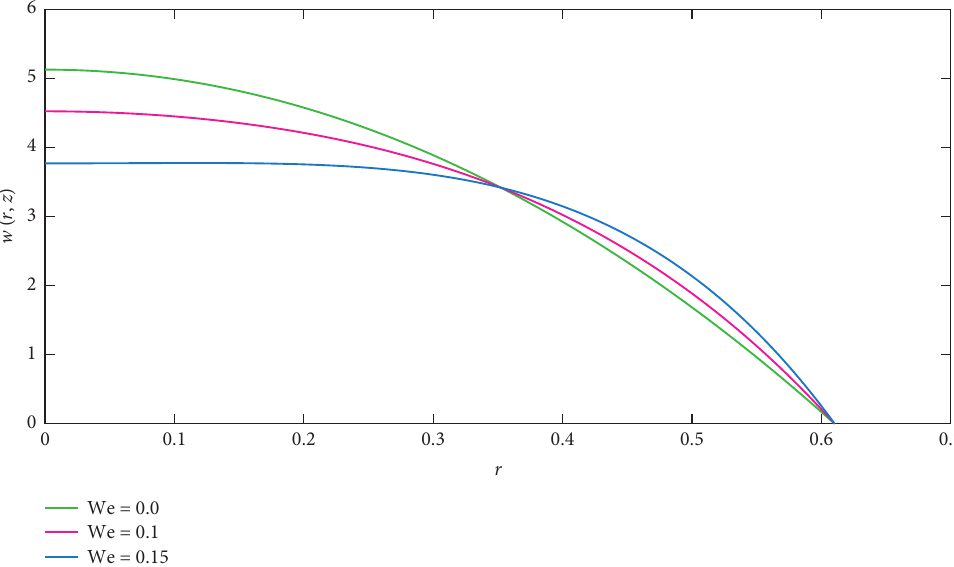
Figure 6: Velocity variation for the Carreau model for n � 2 ,L � 1 , F � 3 , and m � 0 .